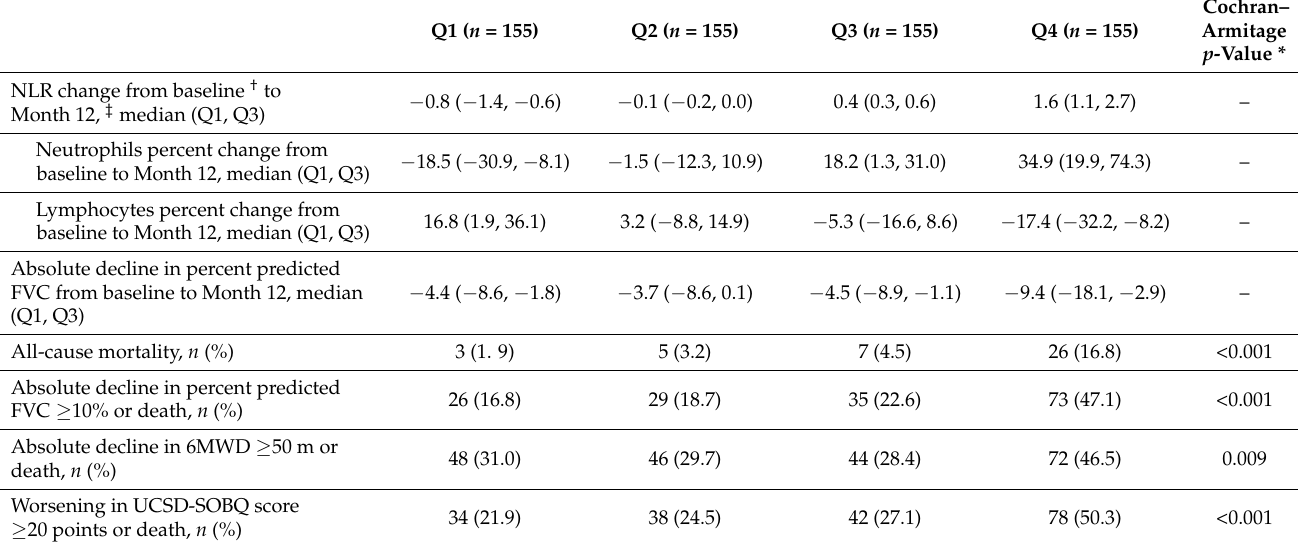
Table 3. Month 12 endpoints based on quartiles as defined by NLR changes from baseline to Month 12 in patients with IPF (pooled from the placebo groups of ASCEND and